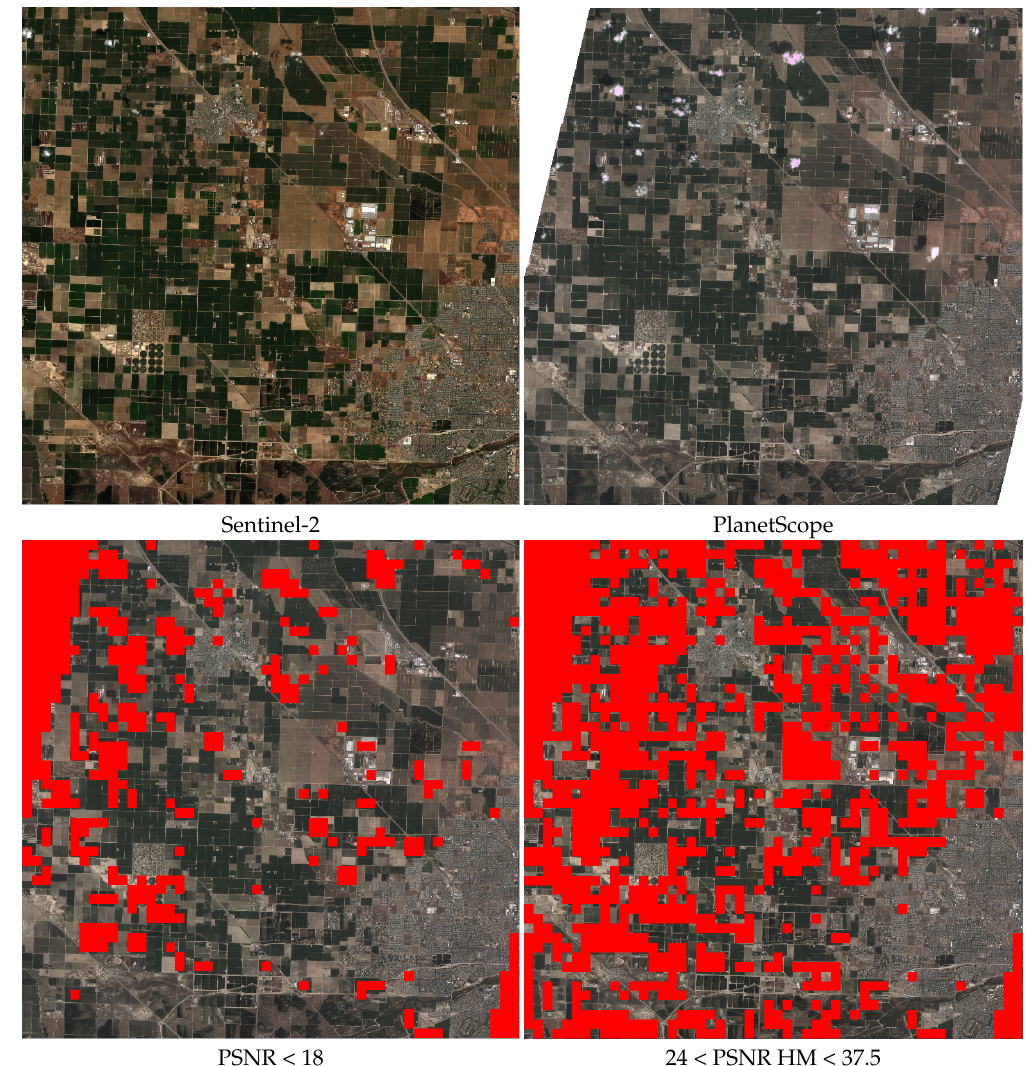
Figure 7. Results of the automatic patch validation process over Shafter